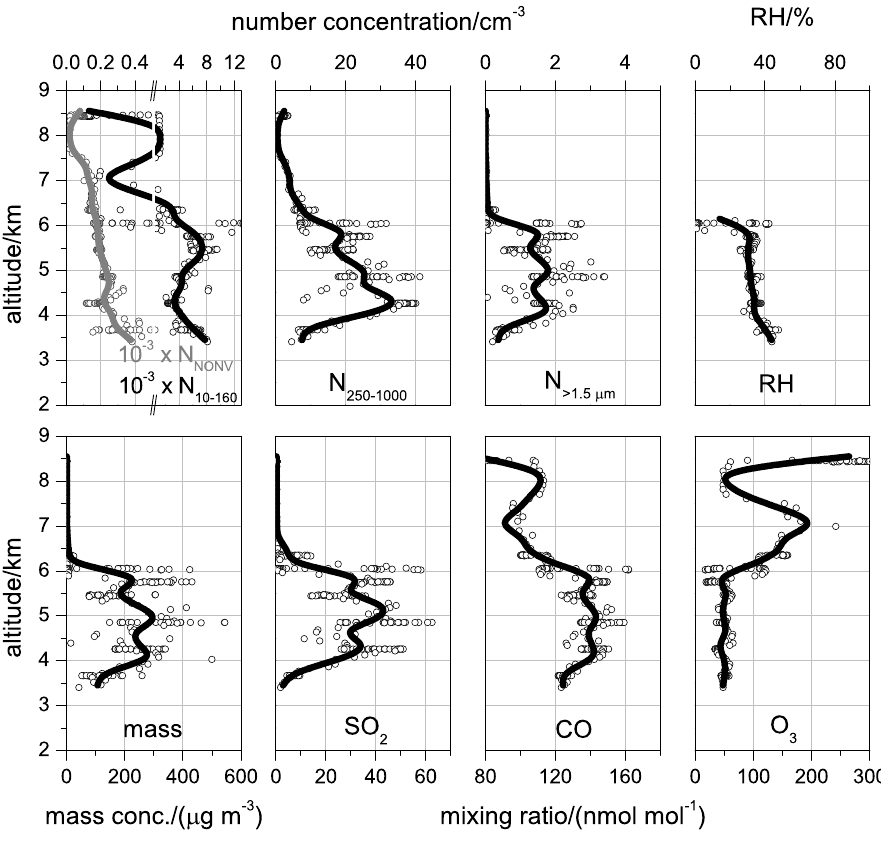
Fig. 17. Number concentrations of total aerosol particles in three size classes (10–160nm, 0.25–1.0µm and > 1 . 5µm) and non-volatile particles ( > 14nm), relative humidity RH, particle mass concentration (case M), and mixing ratios of sulfur dioxide, carbon monoxide and ozone versus altitude during Falcon descent over the North Sea, 15:41:00–16:32:00UTC 17 May. Dots represent 10-s mean data and curves the 300-m-median.